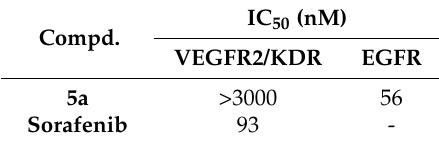
Table 3. EGFR and VEGFR2/KDR kinases inhibitory activity of compound 5a in vitro.